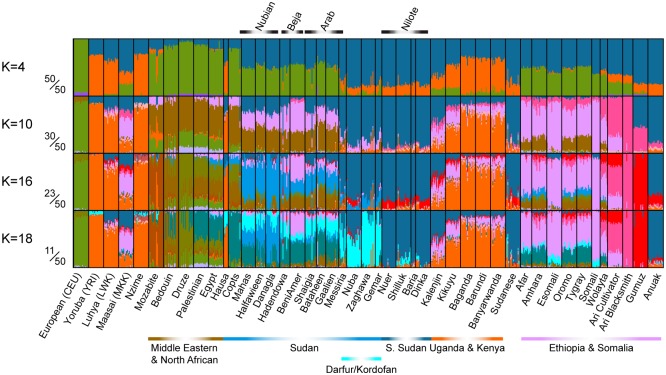
Inferred admixture fractions [51] for different choices of number of clusters.Four different numbers of clusters are displayed. The fractions on the left show the fraction of 50 replicate analyses that support of the most common and displayed mode [52]. Populations that did not contribute to the African variation were removed from this figure. See S3 Fig for the full range of populations and additional K. The bars on top represent the ethnic group, the bars on the bottom indicate geographic grouping.